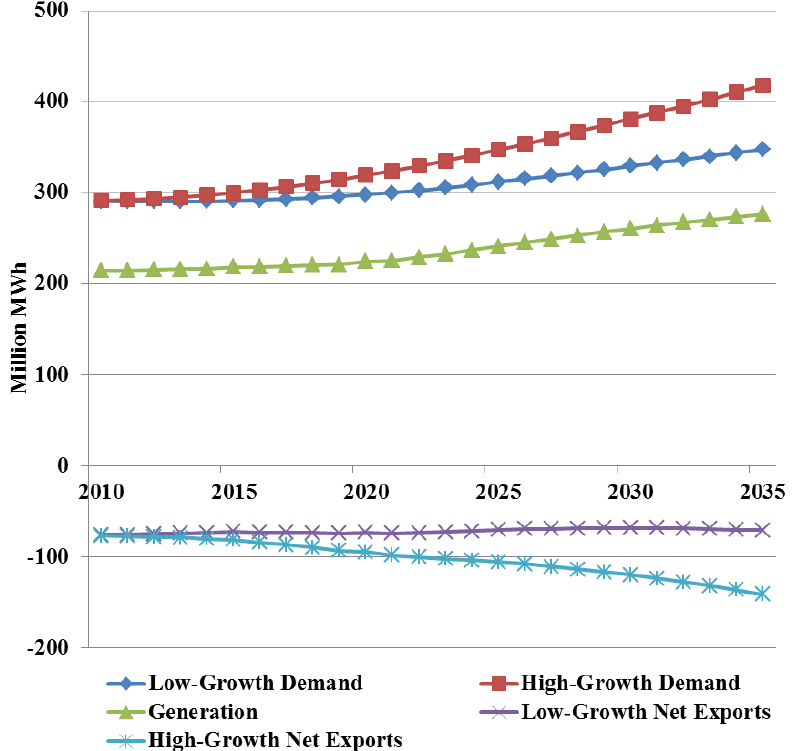
Figure 9. Projected electricity demand and